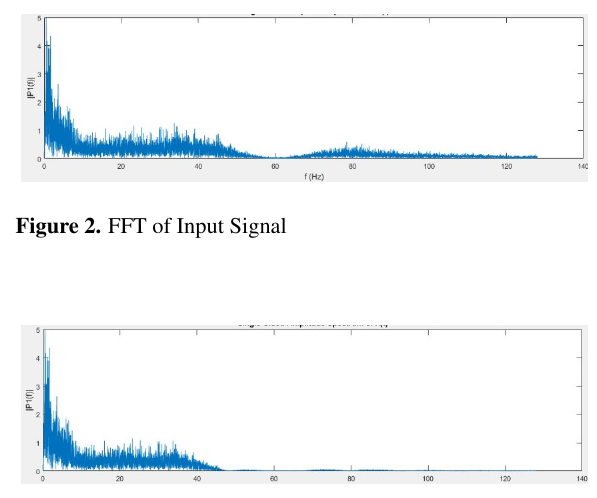
Figure 3. FFT of Output Signal